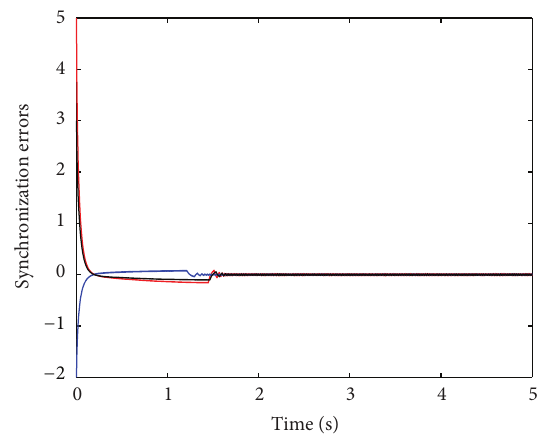
Figure 10: Synchronization errors states in the presence of system- atic uncertainties and external disturbances with 𝛼 = 0.5 (red line represents the first error state 𝑒 1 , blue line represents the second error state 𝑒 2 , and black line represents the third error state 𝑒 3 ).